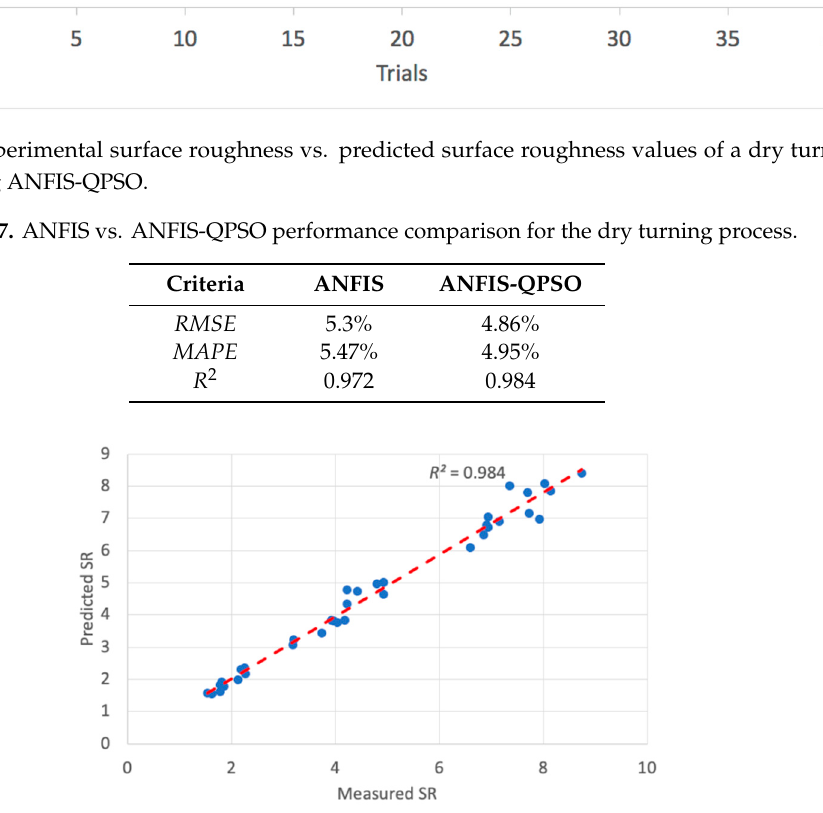
Figure 8. Coefficient of determination of ANFIS-QPSO prediction results for the dry turning process.